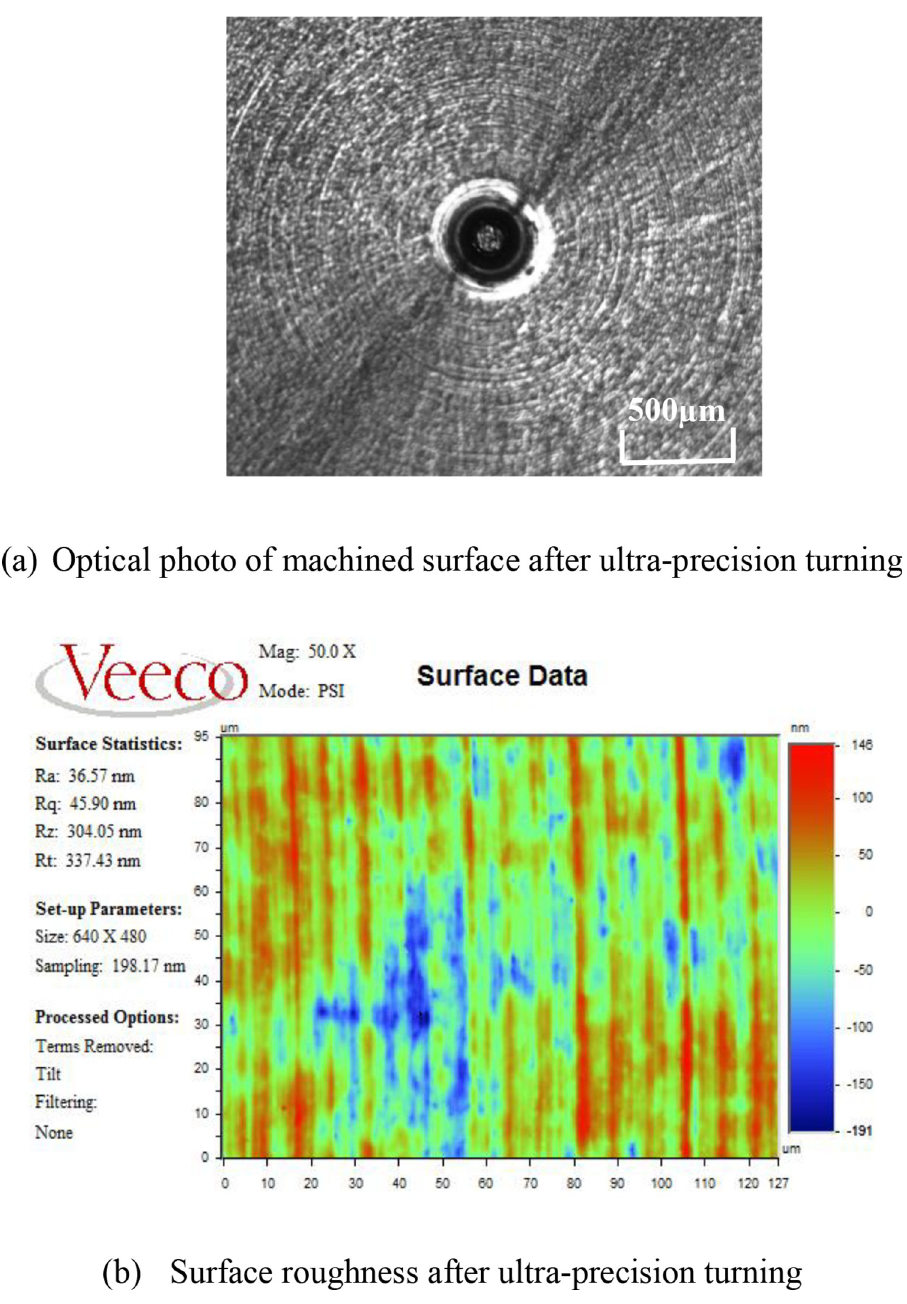
Fig 2. Surface profile of one of Ti6Al4V